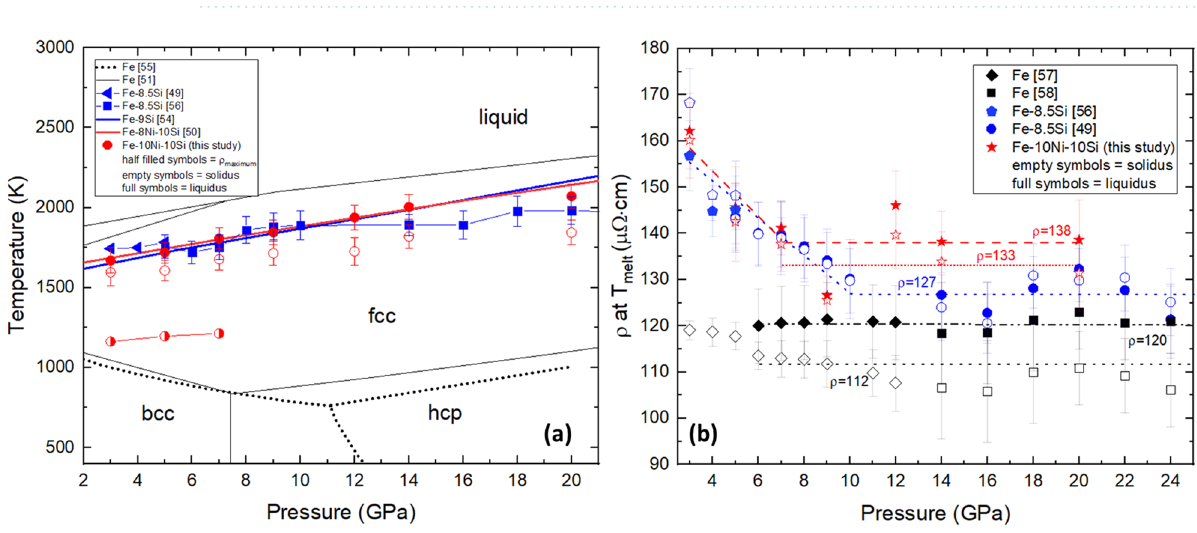
Figure 3. ( a ) T - and P -dependence of Fe10Ni10Si compared to the calculated phase diagram of Fe 51,55 . Comparisons are made with Fe8.5Si 49,56 , Fe9Si 54 and Fe8Ni10Si 50 . The empty symbols represent T at the start of partial melting, T solidus , while filled symbols are T at the end of partial melting, T liquidus . The temperature at the maximum ρ observed near 1200 K from 3 to 7 GPa are illustrated by the half-filled symbols. ( b ) Electrical resistivity of Fe10Ni10Si near melting for various P . Results are compared with Fe 57,58 and Fe8.5Si 49,56 of Fe10Ni10Si is 133 µΩcm and 138 µΩ cm at T solidus and T liquidus , respectively. These values are higher than the reported constant value of Fe8.5Si of 127 µΩcm, and that of Fe of 112 µΩ cm and 120 µΩ cm, on the solid and liquid sides of the melting boundary, respectively. The constant behaviour along the melting boundary may be attributed to insignificant changes in Fermi surface and mean free path upon melting 57 . The calculated k e , shown in Fig. 4a, increases almost linearly with T which is different than the behaviour of pure Fe in the low temperature region but similar to the high temperature region 57 . A multi-variable linear regression analysis of the ρ values in the solid state from this study provides the following model of solid k e ( T , P ):